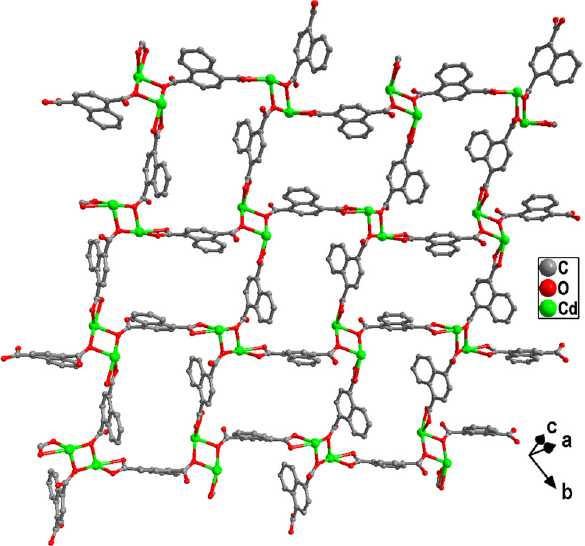
Figure 2: View of the 2D layer structure of 1 constructed by the 1,4 -